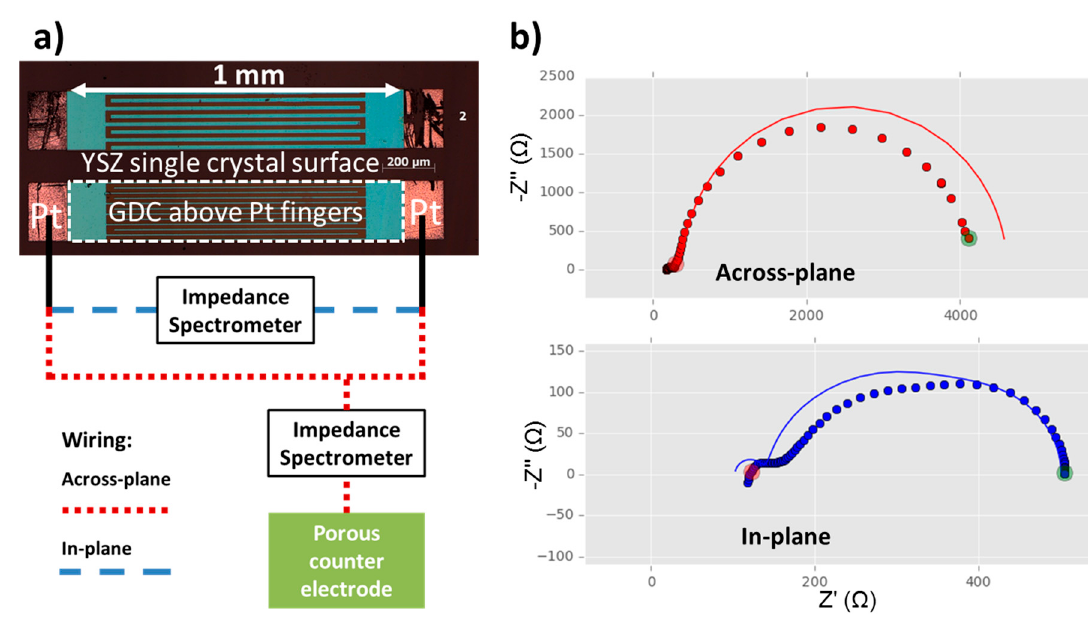
Figure 2. ( a ) Optical micrograph of GDC model composite microelectrodes (bright blue rectangles with dashed white frame) on top of buried interdigitated Pt current collectors with a circuit diagram for the measurements in across- and in-plane mode according to reference [25]. The Pt current collectors are slightly larger than the GDC electrode for easier contacting (bright red rectangles). The layer sequence and the placement of the counter electrode in the cross sectional view is analogous to Figure 1a; ( b ) Measured data—shown as dots—and fits to the equivalent circuit model according to reference [25]—shown as lines—for in- and across-plane measurements of a model composite microelectrode with buried Pt current collectors. Both spectra are fitted simultaneously by one and the same parameter set. The interdigitated current collectors had a width and spacing of both 30 µm and a length of 980 µm with a total of 12 digits. Measurements were performed at 750 °C in humidified ~2.5% vol H 2 in Ar, with a ratio of hydrogen to water of 1:1.